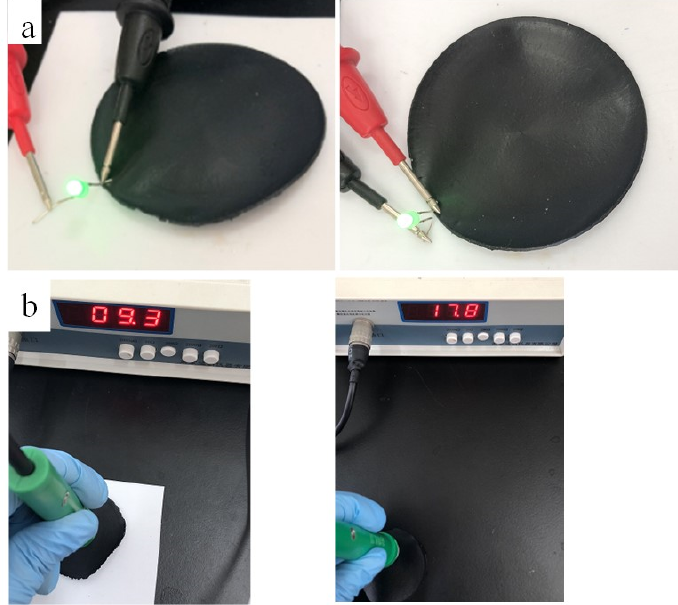
Figure 16. ( a ) Photos of light emitting diode devices on the conductive composite film without crack (left) and after healing (right), ( b ) testing photos of on the conductive composite film without crack (left) and after healing (right).